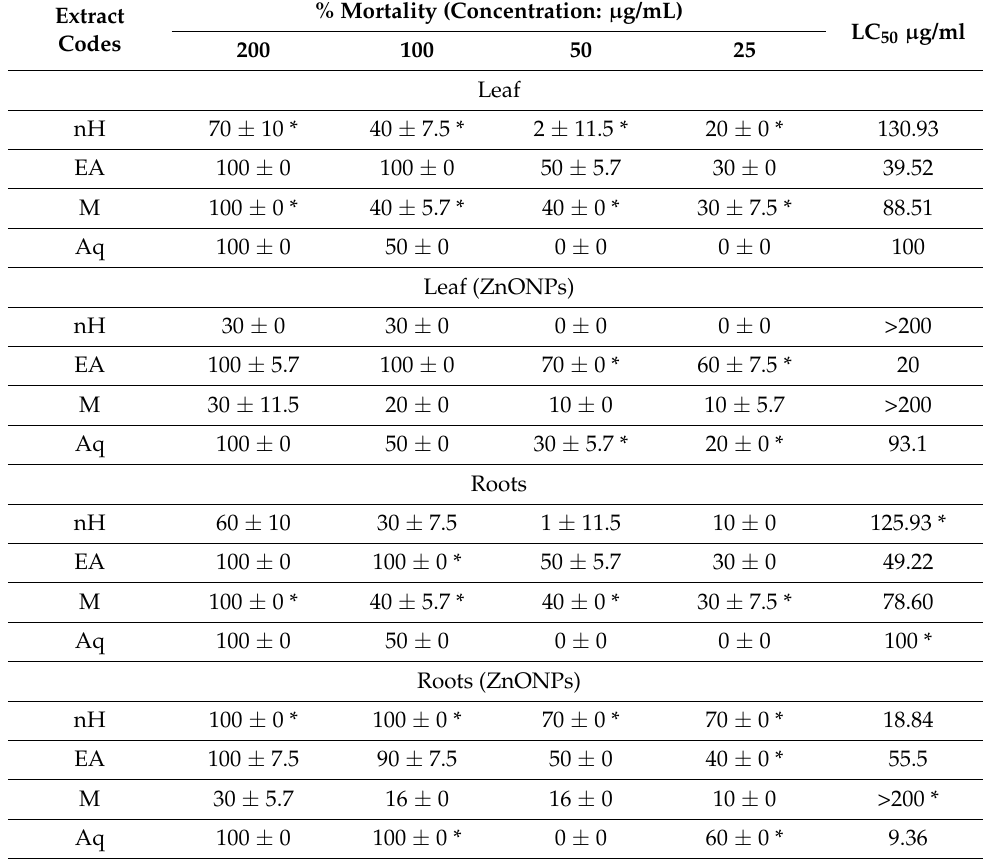
Table 4. Brine shrimp lethality potential of W. somnifera crude extracts and